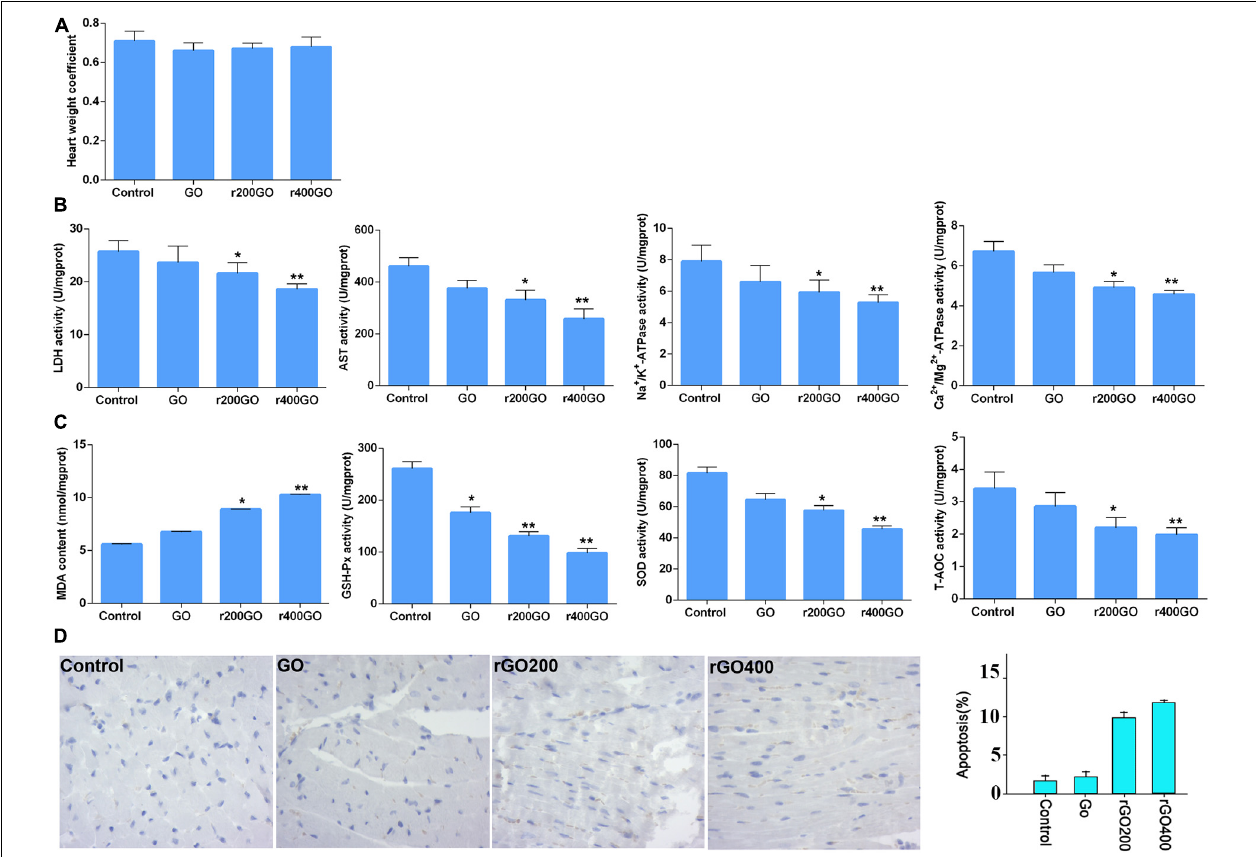
FIGURE 6 | Graphene oxide (GO) and reduced GO (rGO) exerted cardiotoxicity in mice. (A) The heart weight coefficient of mice after GO or rGO injection ( n = 10 in each group). (B) The activities of several myocardial enzymes, including lactate dehydrogenase (LDH), aspartate aminotransferase (AST), Na + /K + -ATPase, and Ca2 + /Mg2 + -ATPase, in the myocardial tissues after GO or rGO injection ( n = 10 in each group). (C) The activities of lipid peroxidation indicators, including malondiadehyde (MDA), superoxide dismutase (SOD), glutathione peroxidase (GSH-Px), and total antioxidant capacity (T-AOC), in the myocardial tissues after GO or rGO injection ( n = 10 in each group). (D) The apoptosis of cardiac cells in mice heart section as detected by TUNEL assay. Representative images were shown on the left, and the quantified bar graph was shown on the right ( n = 3). * p < 0.05; ** p <